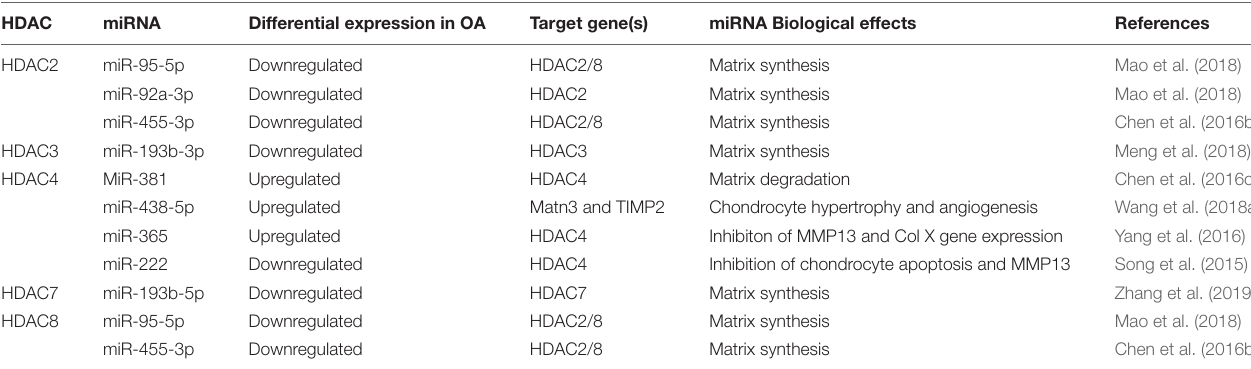
FIGURE 1 | Classification of HDACs (A) and the different mechanism of action (B) . TABLE 1 | The relationship between HDACs and miRNAs in